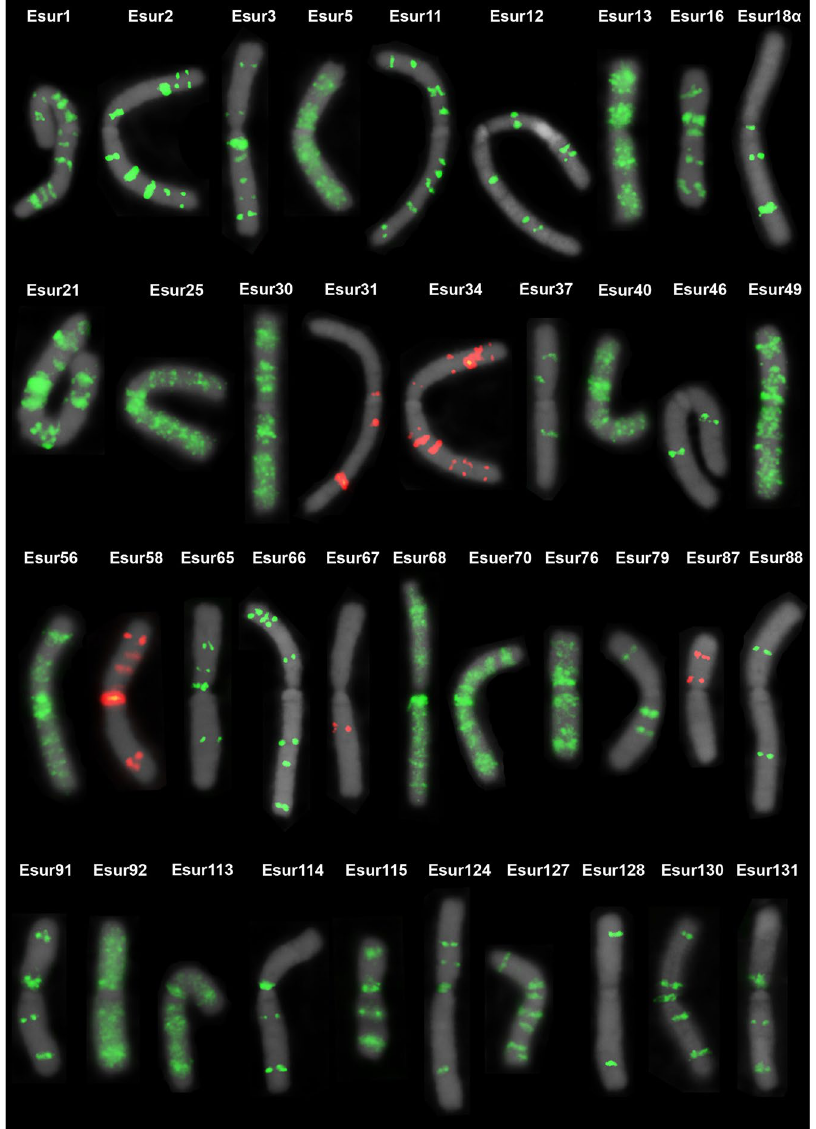
Figure 3. Distribution of the 39 satDNAs in the neo-Y chromosome of E . surinamensis